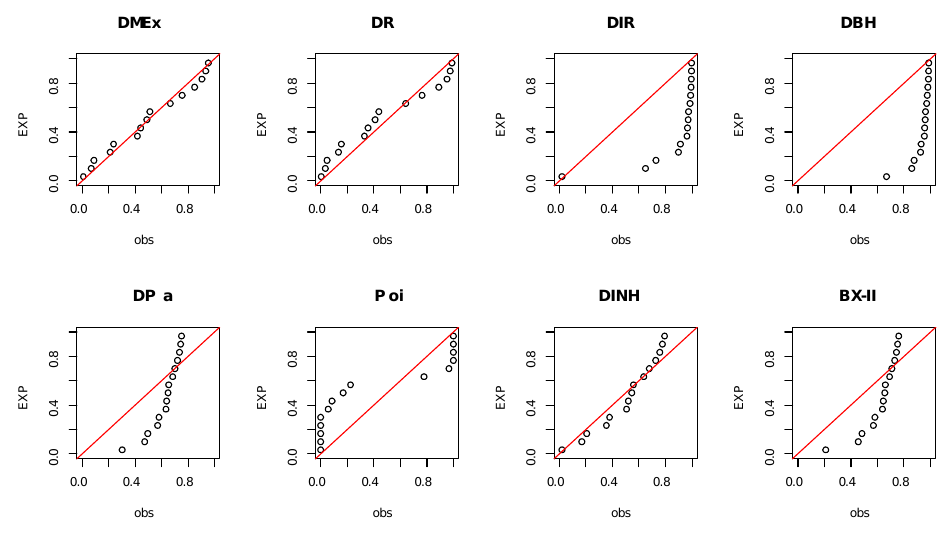
Figure 10. P-P visualization plots for EC data. Figure 10 . P-P visualization plots for EC data.